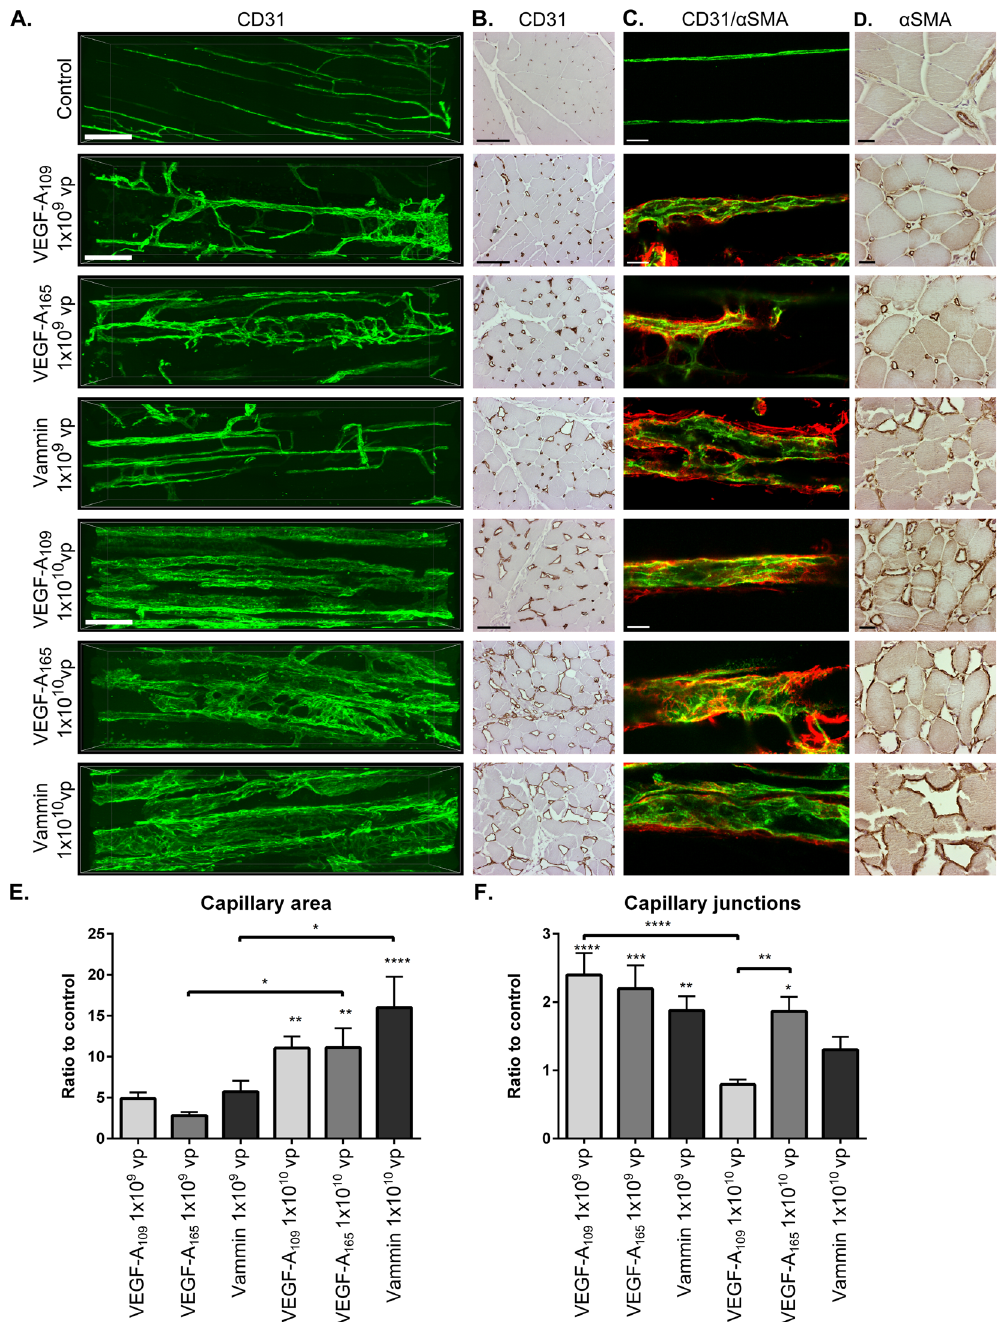
Figure 3. Both VEGF-A forms and Vammin induce dose and receptor binding profile specific changes in the vascular network ( A ). Multiphoton microscopy imaging of the blood vessel network by CD31 (green) labelled blood vessels from longitudinal sections of semimebranosus muscle. With 1 × 10 9 vp dose all tested factors induce sprouting angiogenesis and modest enlargement of capillaries. With 1 × 10 10 vp dose, the normal organization of the blood vessel network is disturbed. VEGF-A 109 induces enlarged capillaries that have notably few connections and sprouts. Scalebar 100 µ m. ( B ) CD31 staining of paraffin embedded cross-sections of semimembranosus muscle. Scalebar 100 µ m. ( C ) Confocal microscopy images from CD31 (green) and α SMA (red) double-stained muscles. α SMA positive staining surrounds the enlarged capillaries. Scalebar 25 µ m. ( D ) α SMA staining of the cross-sections shows high coverage of α SMA positive cells in the enlarged capillaries. In control muscles, the staining is mainly seen in the arterioles and venules. Scalebar 25 µ m ( E ) Quantification of the capillary area as ratio to the controls from paraffin embedded CD31 stained cross sections (n = 4–6 per group) ( F ) Quantification of the amount of capillary junctions as a ratio to the controls from confocal microscopy images of CD31 stained whole-immunomounts (n ≥ 9 images per group). In E to F the data is presented as mean ± SEM. * P < 0.05, ** P < 0.01, *** P < 0.001, **** P <